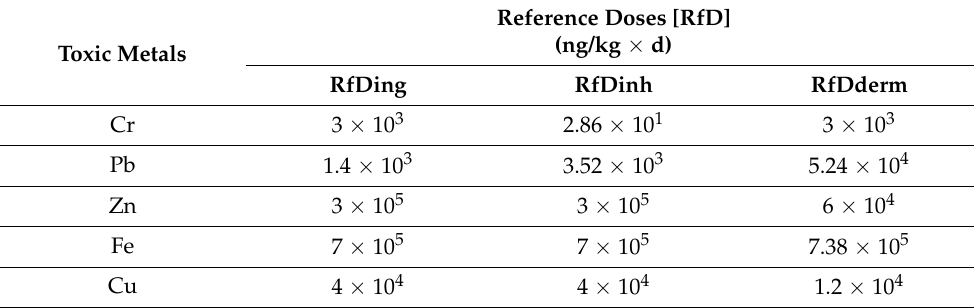
Table 3. Reference doses (RfD) for the selected